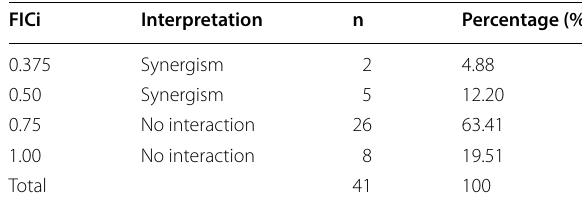
Table 2 Values obtained of interaction between AgNP and KTZ against M. furfur using checkerboard assay